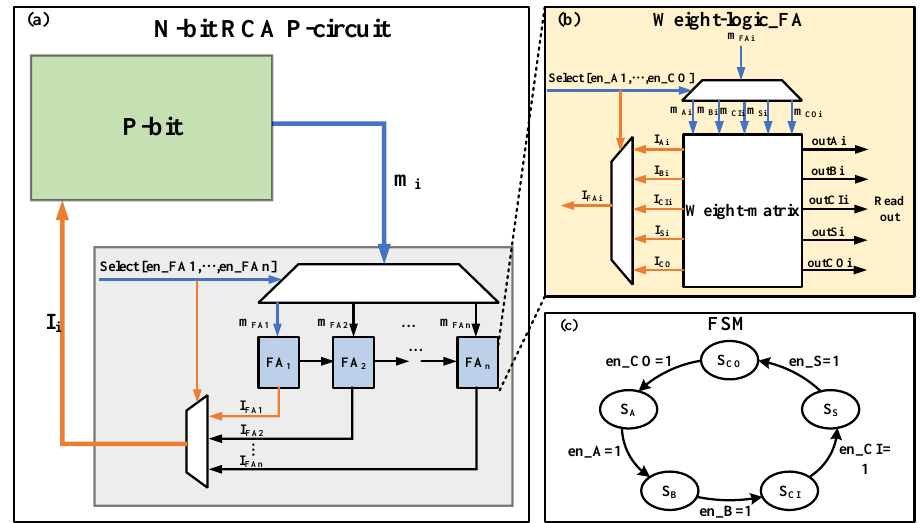
Figure 5. Proposed N-bit ripple carry adder (RCA). ( a ) The structure of N-bit RCA p-circuit using two-multiplexing strategy; ( b ) the structure of FA using time-division multiplexing; ( c ) the calculation process in the weight-matrix.